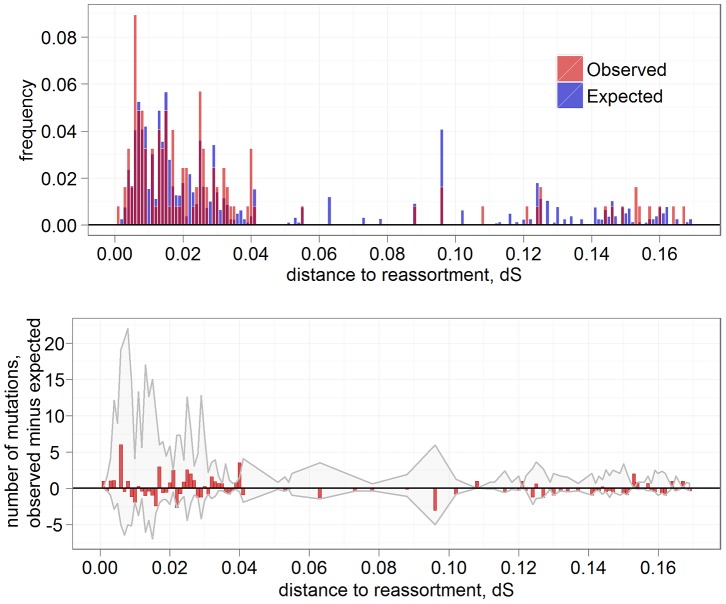
Excess of amino acid replacements after RCBs in PB1.Top: frequencies of amino acid replacements observed at various phylogenetic distances from the most recent ancestral reassortment; pink: observed; gray: expected; red: overlayed observed and expected. Bottom: the excess of amino acid replacements, compared to the expectation. Gray shaded area indicates the 90% CI for the expected value. The expected distribution was obtained from 10,000 reshuffling trials.